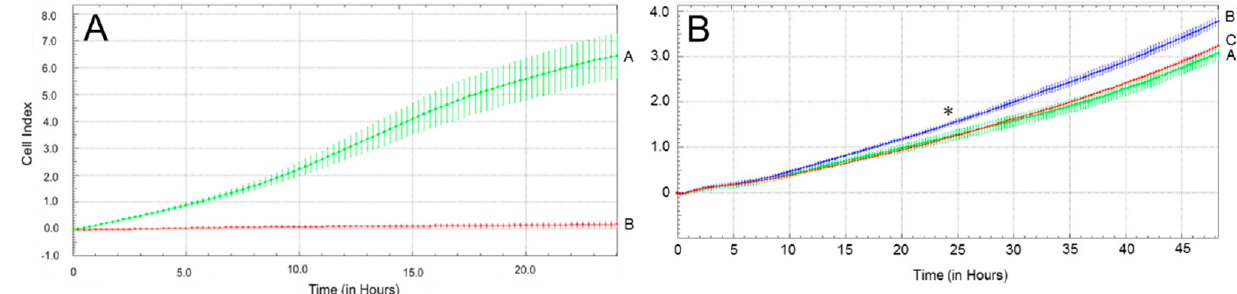
Figure 6. Measurement of basal and TGF- β -induced migratory capacity of LuPanc-1 and LuPanc-2 cells. ( A ) Both cell lines (green curve/tracing A: LuPanc-1, red curve/tracing B: LuPanc-2) were subjected to a real-time cell migration assay on an xCELLigence platform for 24 h. The relative migratory activity is plotted on the ordinate and given as the dimensionless Cell Index. Data are the mean ± SD of quadruplicate wells. The assay shown is representative of three assays performed in total. ( B ) The same procedure as that in ( A ), except that LuPanc-1 cells were assayed in the absence (green curve/tracing A) or presence (blue curve/tracing B) of rhTGF- β 1 (5 ng/mL) for 48 h. In another four wells, cells were treated with rhTGF- β 1 plus the ALK5 serine/threonine kinase inhibitor SB431542 (5 µ M, red curve/tracing C). Data shown are the mean ± SD of quadruplicate wells from one out of two assays. The asterisk ( ∗ ) marks the time point at which the difference between TGF- β 1-treated and untreated control cells was first statistically significant. Differences remained as such until the end of the assay. No significant differences were noted between the untreated control and the rhTGF- β 1 + SB431542-treated cells.